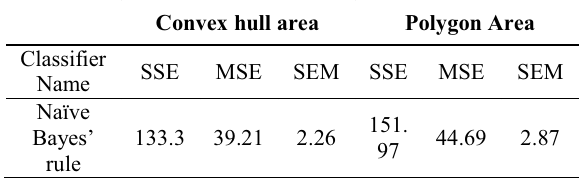
Table 16. Different Error measurements on Distance Metrics